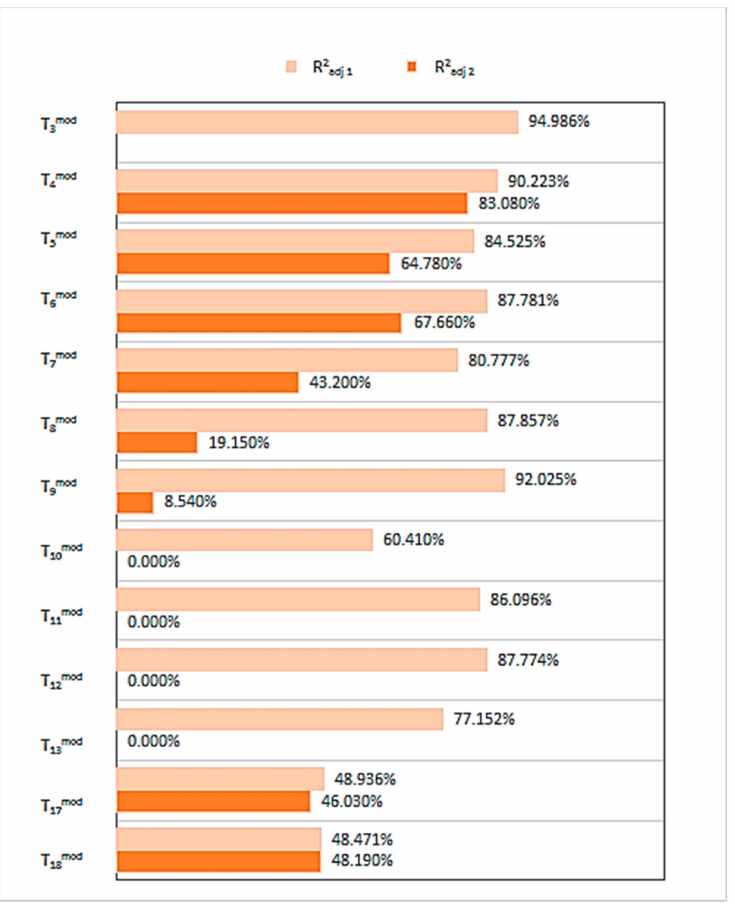
and the second adj 1